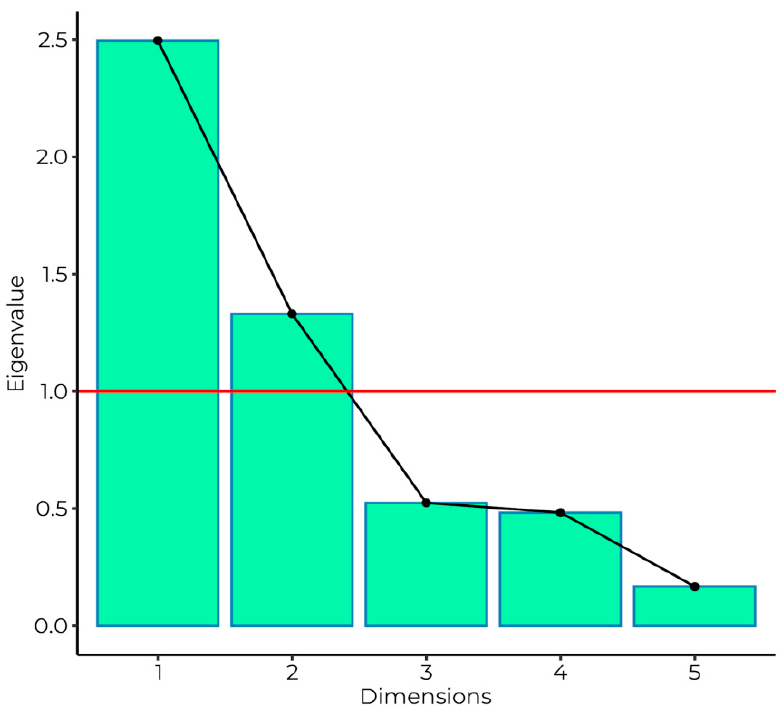
Figure 1. Scree plot illustrating the eigenvalues of subsequent principal components. The Kaiser criterion cutoff point was presented as the red line. Only two first dimensions fulfilled the formal criterion and were included in further analysis.